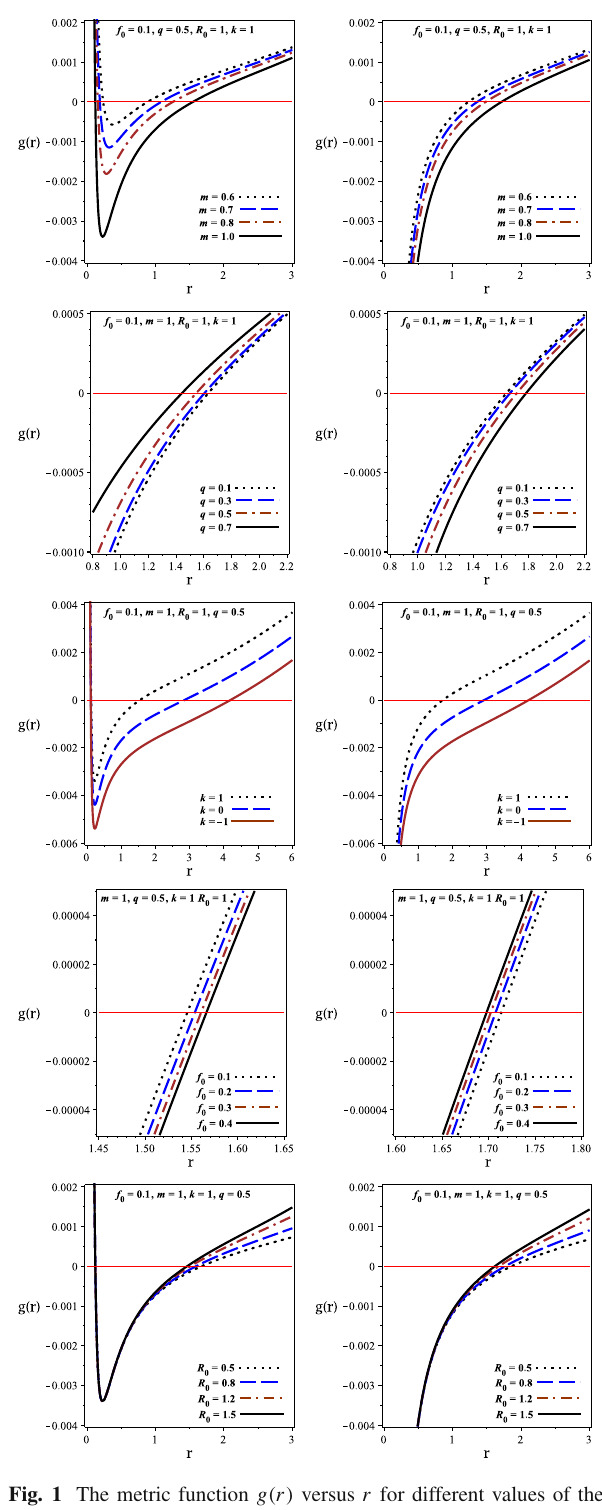
Considering F μν = ∂ μ A ν − ∂ ν A μ , one can find the nonzero component of the gauge potential in which is A t